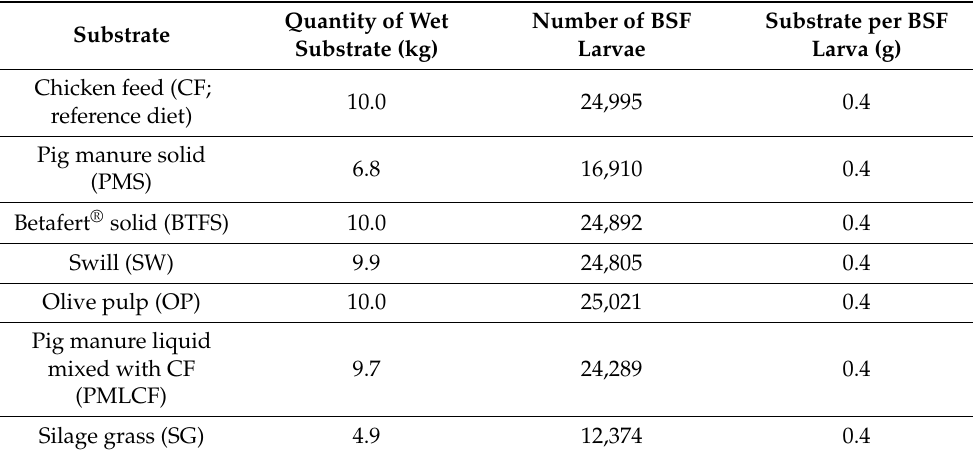
Table 1. Quantity of substrate, number of larvae per container and available substrate per